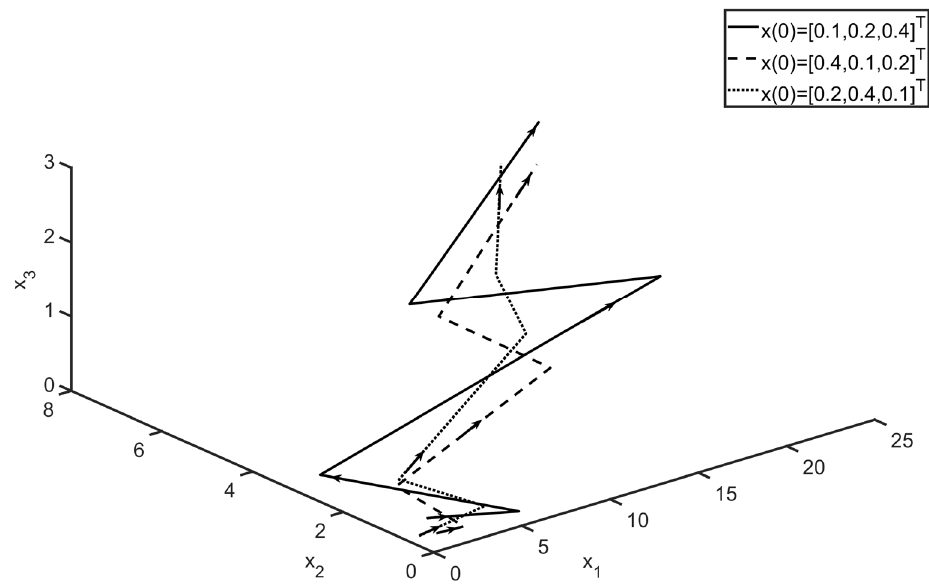
Figure 2. Trajectories tending to the positive equilibrium.